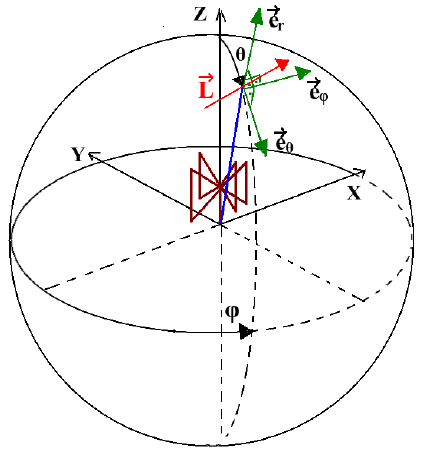
Figure 4. The spherical coordinate system with the antenna in the center. The zenith angle θ is counted from the top, the az- imuth angle φ from the x-axis (along NS direction) of the coor- dinate system. The RF signal arrives from a specific direction ( θ,φ ). The VEL (cid:126) L for the specified direction is